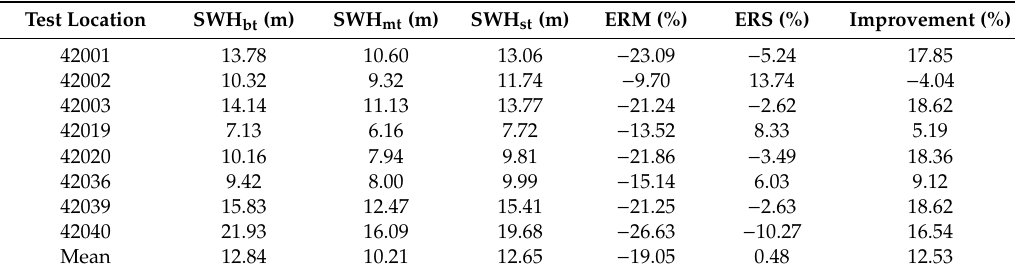
Table 6. Gulf of Mexico: results for T R = 100